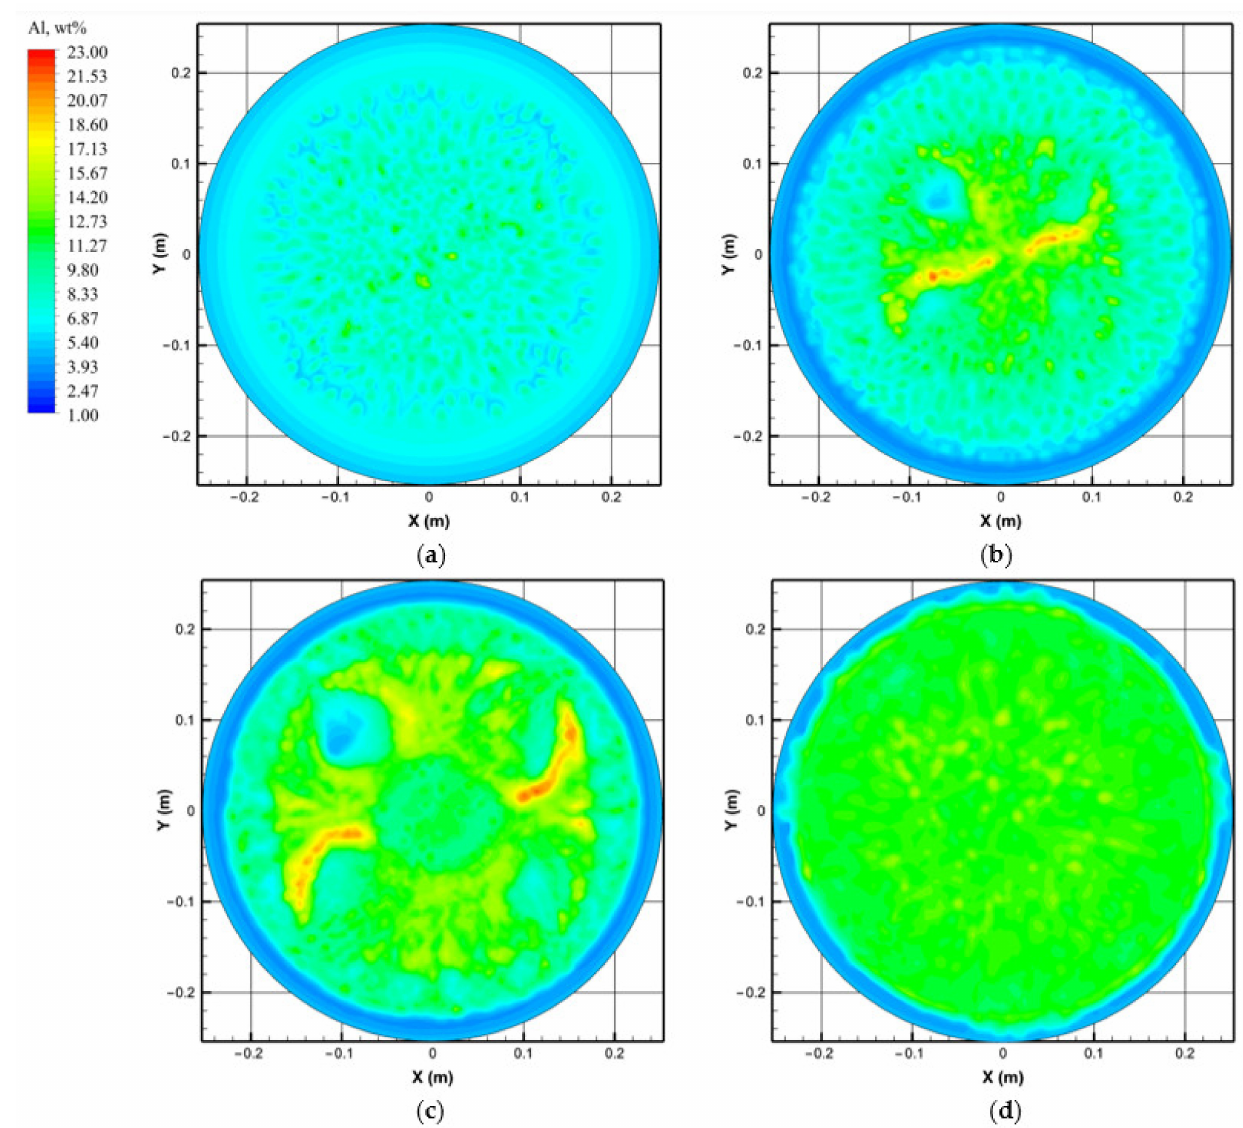
Figure 12. Solute distribution of horizontal sections inside the ingot after solidification: ( a ) Z = 0.1 m; ( b ) Z = 0.25 m; ( c ) Z = 0.35 m; ( d ) Z = 0.45